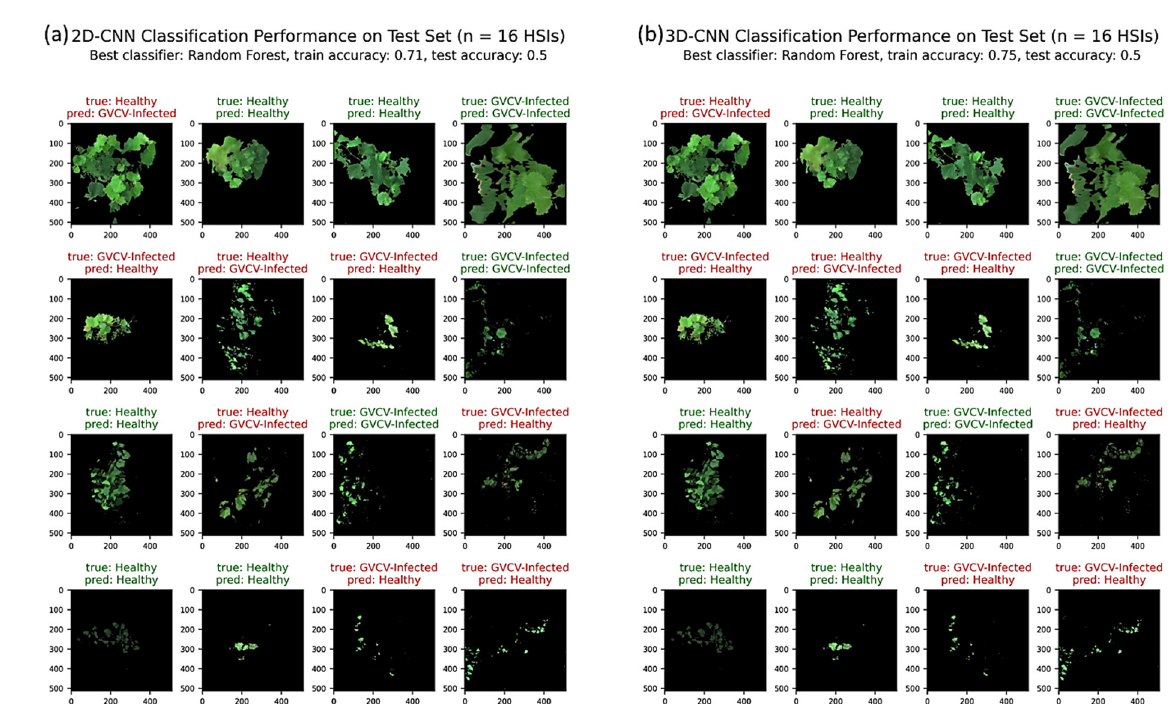
Figure 10. Classification performance of 2D-CNN ( a ) and 3D-CNN ( b ) models on a hold-out test set ( n = 16 HSIs). The RF approach was the best classifier, with 71% validation accuracy for the 2D-CNN model and 75% validation accuracy for the 3D-CNN model. Both correctly classified 50% of 16 HSIs in the test set. The image subtitles indicate true and predicted classes (healthy versus GVCV-infected vines). Green image subtitles indicated a correct classification, while red subtitles indicated an incorrect classification. The row order corresponds to the measuring dates on August 7th, August 29th, September 19th, and October 8th, 2019.